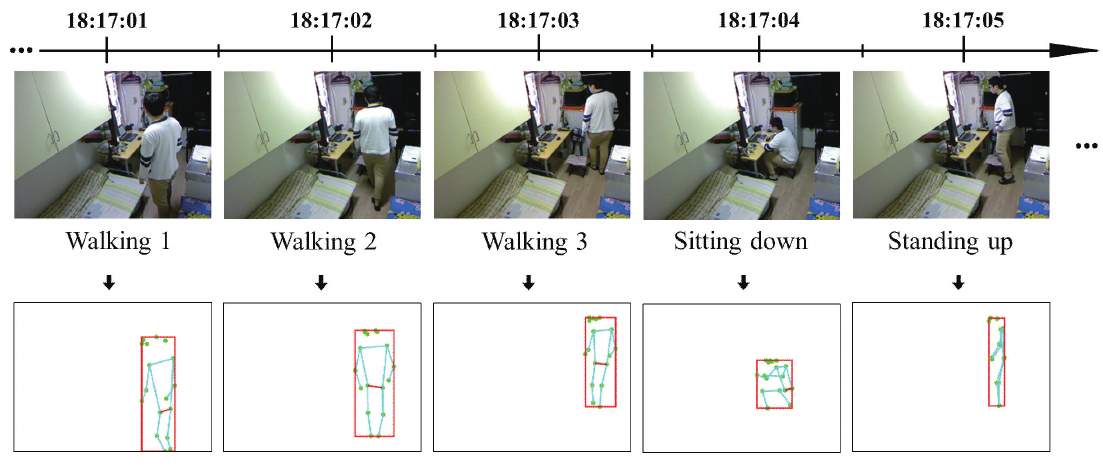
Figure 3. Example of the pose maps representing postural changes in the